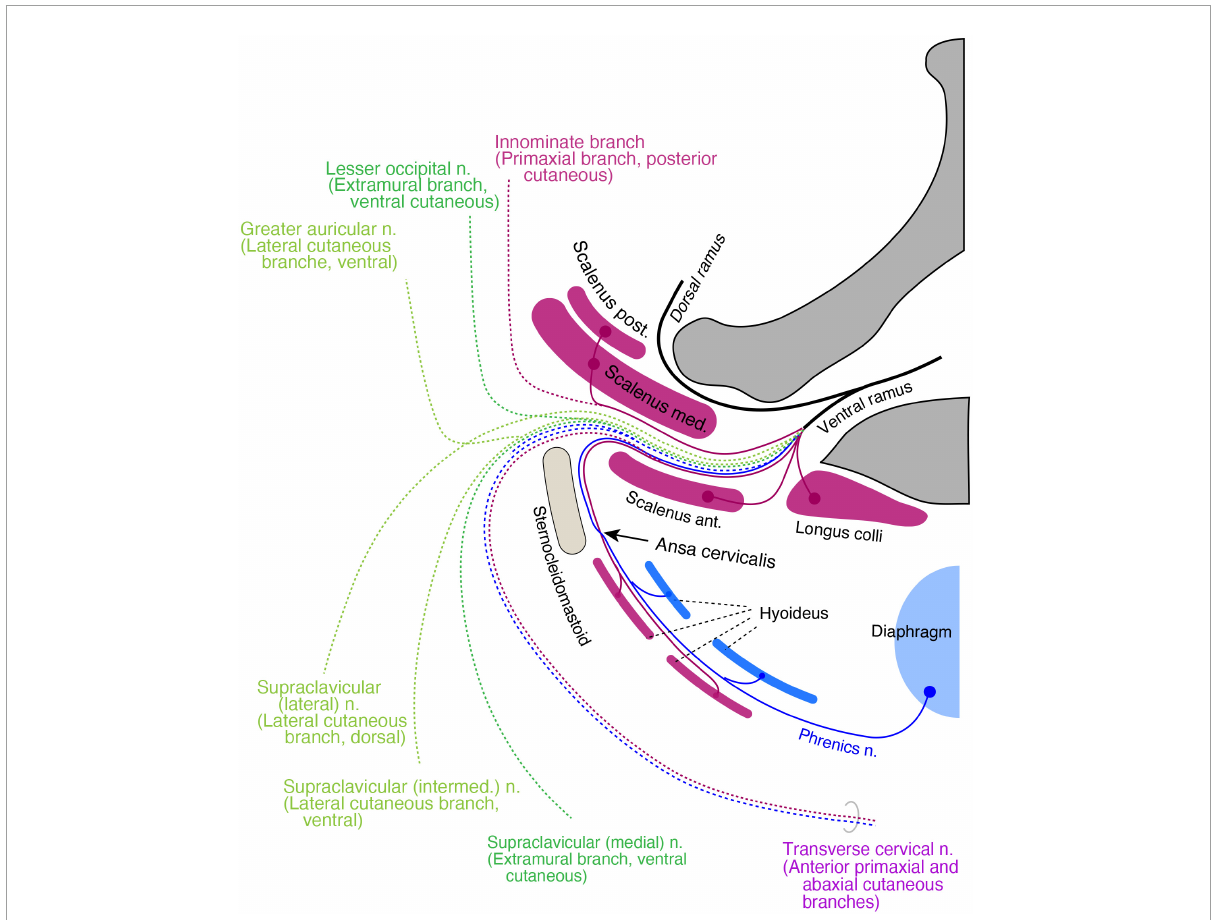
FIGURE12 Hypothetical distribution of three nerve components in the cervical region. The positions of all branches and muscles are projected to a transverse plane of the mid neck. The primaxial motor branches (purple) include direct twigs to the scalene, longus colli, and anterior primaxial branch to the superficial infrahyoid muscles (purple). The intramural motor branches (blue) innervate deep infrahyoid muscles and the diaphragm (blue). The cutaneous branches are dotted lines and color-coded: purple for primaxial branches, blue for the abaxial anterior branch, dark green for the extramural branches, and light green for the LCBs. The posterior primaxial cutaneous branch (purple dotted line) is innominate. The transverse cervical nerve is a combination of the primaxial and abaxial anterior